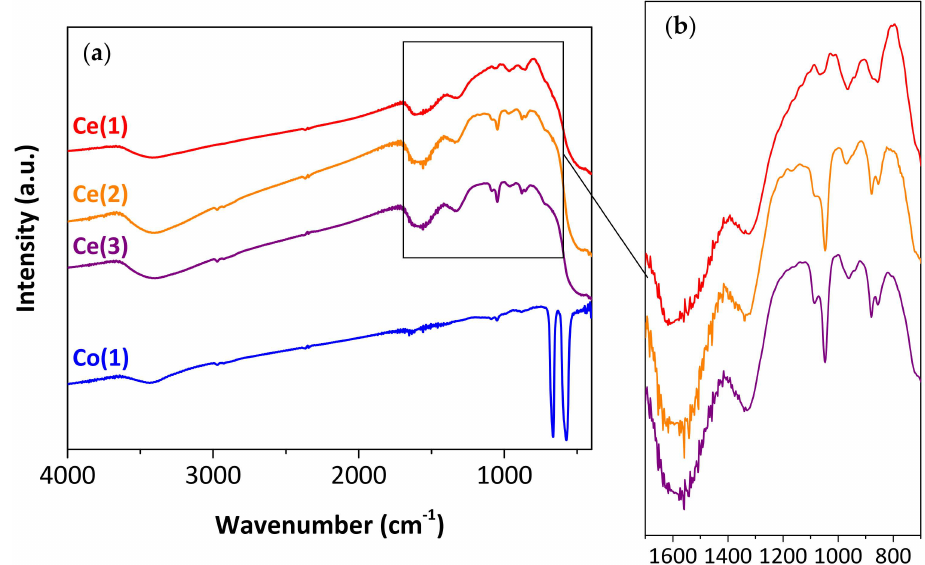
Figure 3. FTIR spectra for all developed samples ( a ) and magnification ( b